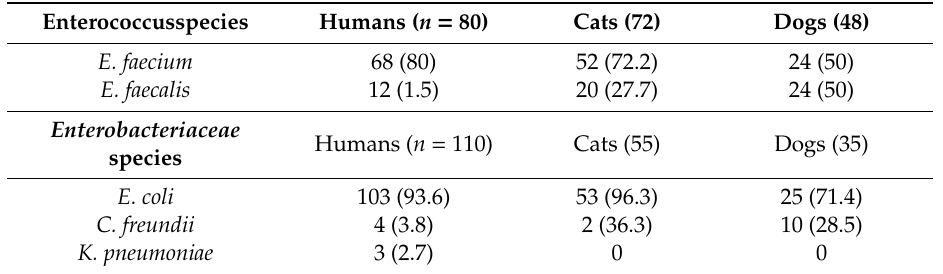
Table 1. Number (%) of isolates of Enterococcus and Enterobacteriaceae from 100 fecal samples of humans, cats, and dogs.